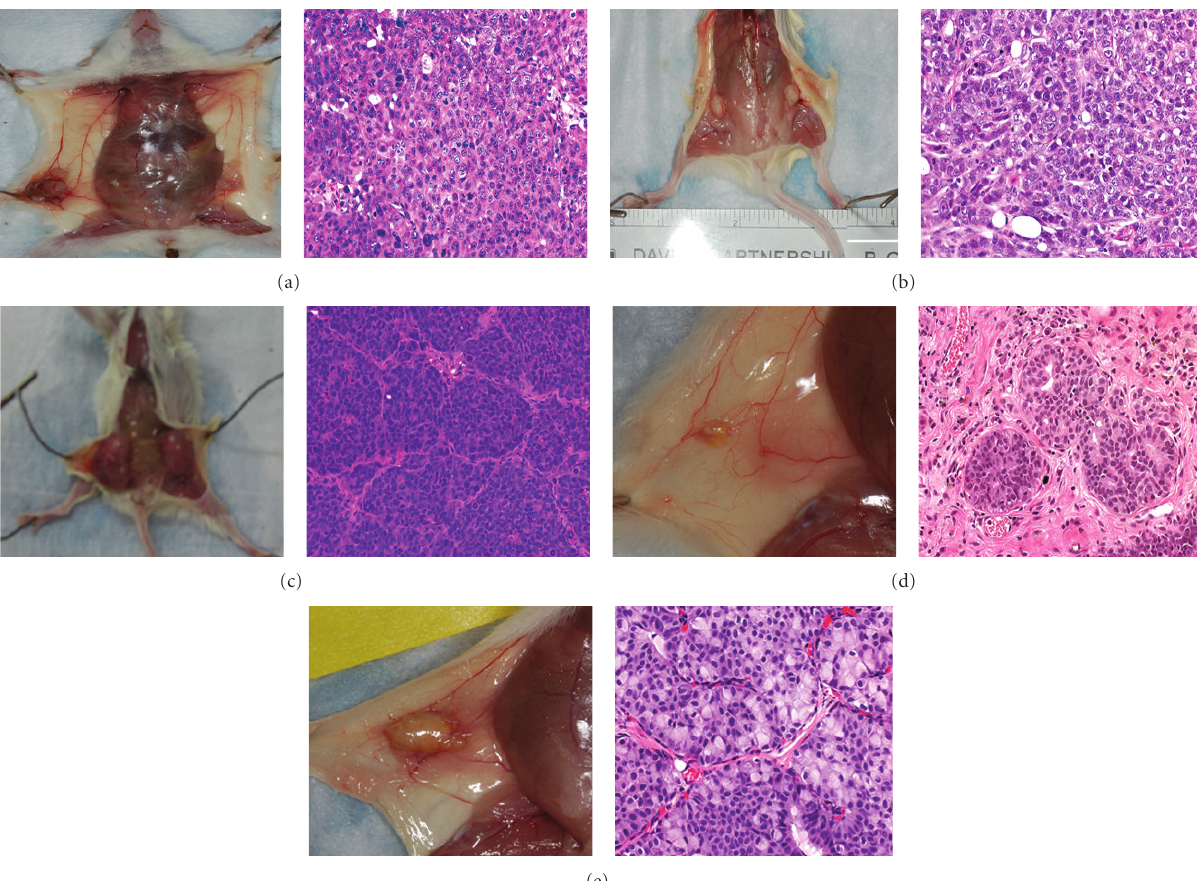
Figure 2: Growth and formation of xenografts by commonly used breast cancer cell lines or human breast tumor tissue in nascent mammary fat pad of NOD/SCID mice. Gross pictures of human xenografts (left panels) and corresponding H&E stained sections of xenografts (right panels) from breast cancer cell lines or human breast tissue implantation (a) SUM1315, (b) MDA-MB-468, (c) DU4475 (magnification 200x), (d) human breast epithelial organoids (magnification 400x), and (e) human breast tumor slices (magnification